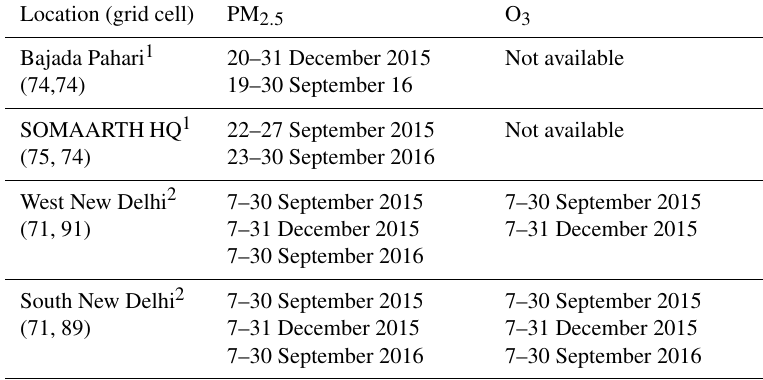
Table 6. Ambient observation data